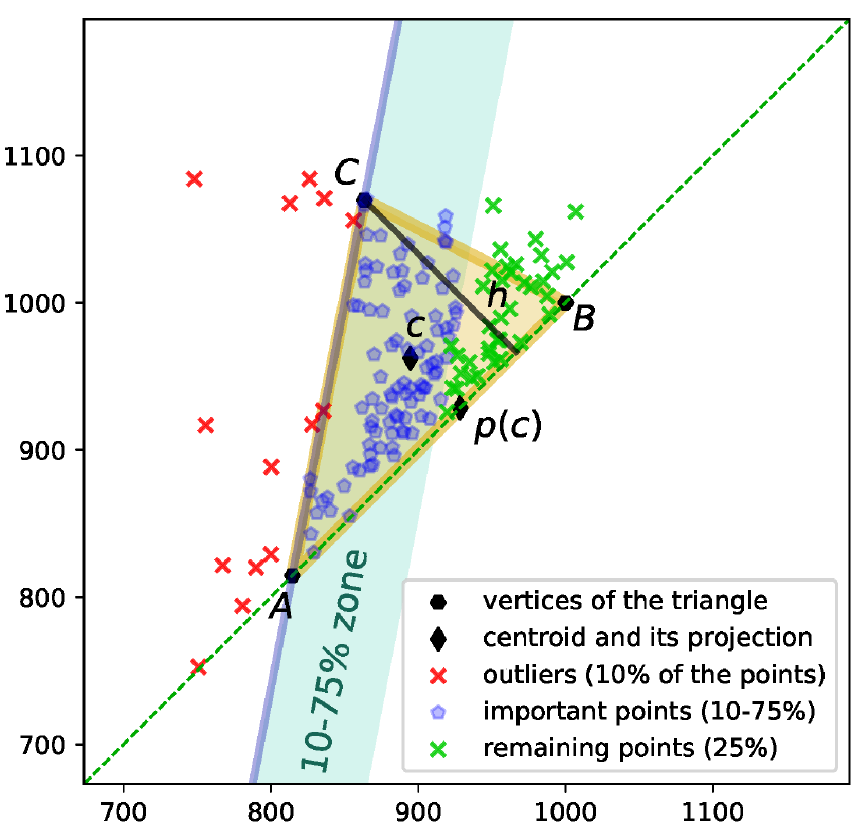
Fig 2. The topological triangle T ( D ) that reflects the shape of the set of points D in the persistence diagram. See explanations in text.